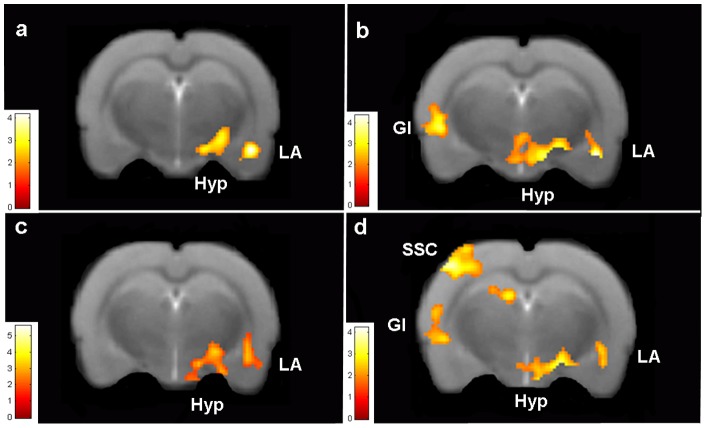
Brain activation maps in response to a fear conditioned stimulus.(a) Activation in PG in response to CS presentation is observed in right lateral amygdala (LA) and hypothalamus (Hyp). (b) Comparison of response between groups (PG:UG) confirms LA, Hyp and granular insular cortex (GI) activation in PG in response to the CS presentation. Extinction modeling of (c) the response across CS presentations within the PG or (d) between PG and UG groups reveals right LA, Hyp, GI and somatosensory cortex activation (SSC). PG, n = 14; UG, n = 10.